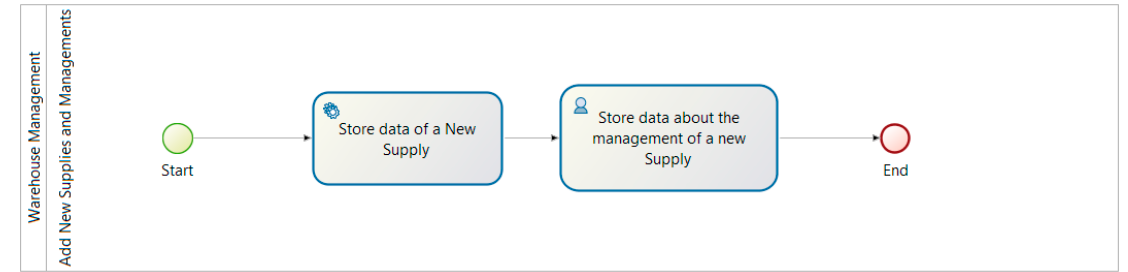
Figure 19. Diagram for the management of a new food supply in the farm warehouse.